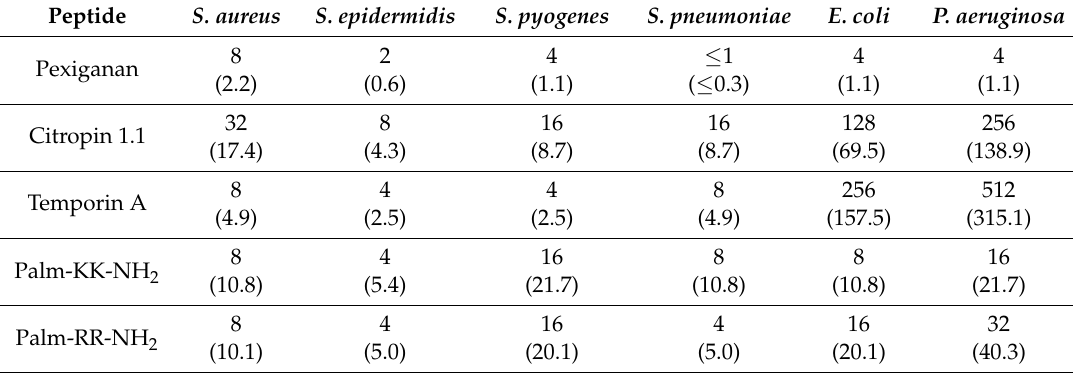
Table 1. Minimum inhibitory concentration of the AMPs in µ g/mL ( µ